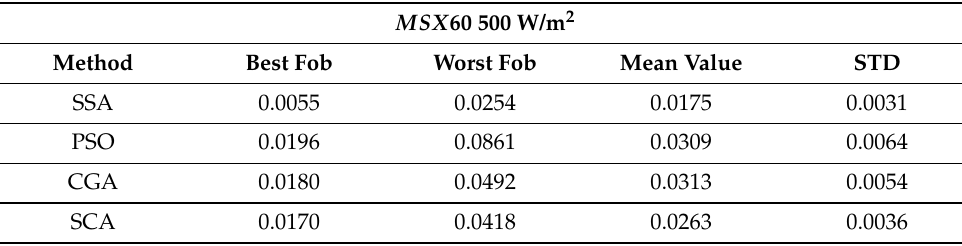
Table 7. Results obtained for the MSX 60 PV panel under a 500 W/m 2 irradiance level.